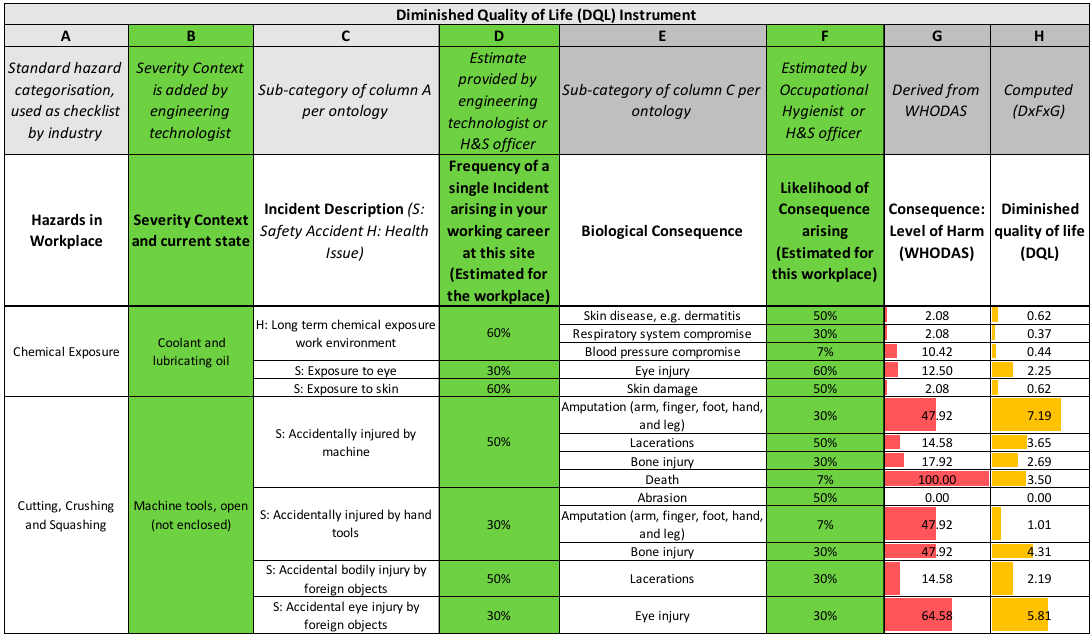
Figure 12. DQL health and safety measuring instrument applied to lathe work.